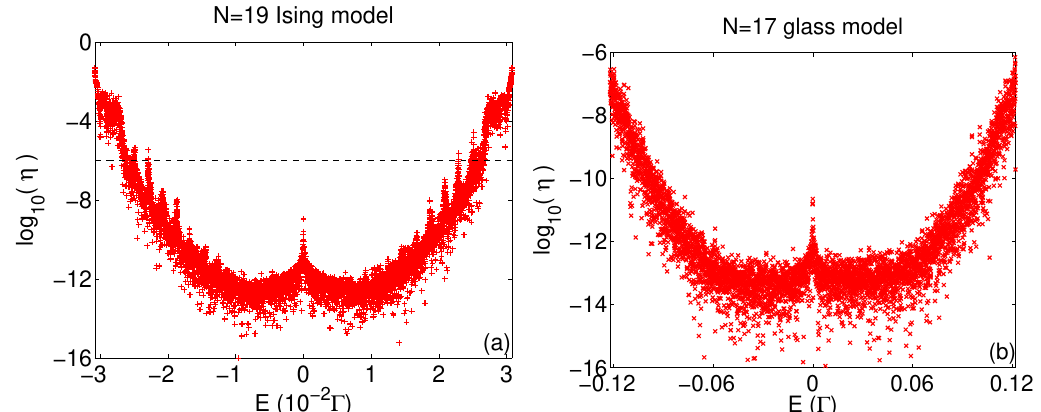
Figure 3: The relative error η in logarithmic scale of the calculated eigenvalues, for (a) Ising model with N = 19 and (b) spin glass shards model with N = 17. The horizontal axis is the system energy. The number of eigenvalues satisfying η < 10 − 6 (black dashed line) is 5,385 for (a) and 5,000 for (b). Such a distribution comes from the shape of filters in Figure